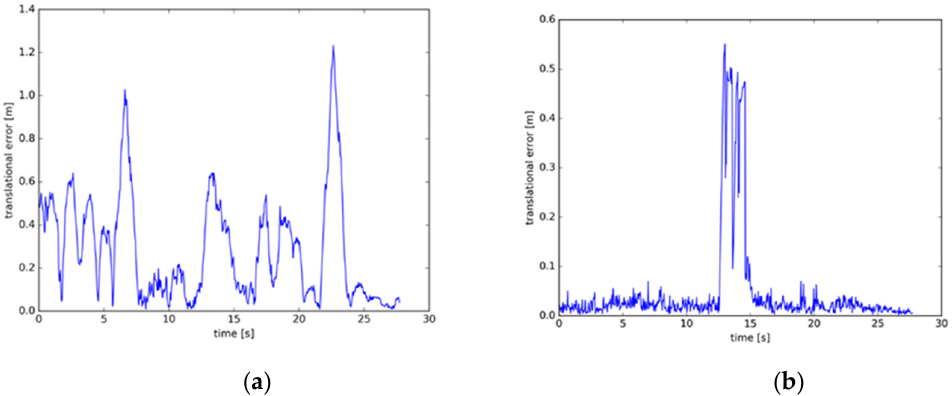
Figure 13. Relative pose error of dataset three: ( a ) The relative pose error of dataset two using ORB-SLAM2; ( b ) The relative pose error of dataset two using instance SLAM based on CO-HDC.